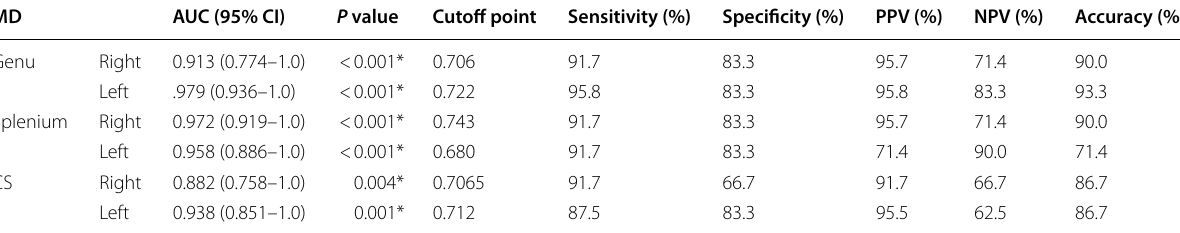
Table 4 Validity of MD genue in discriminating trauma cases from control group